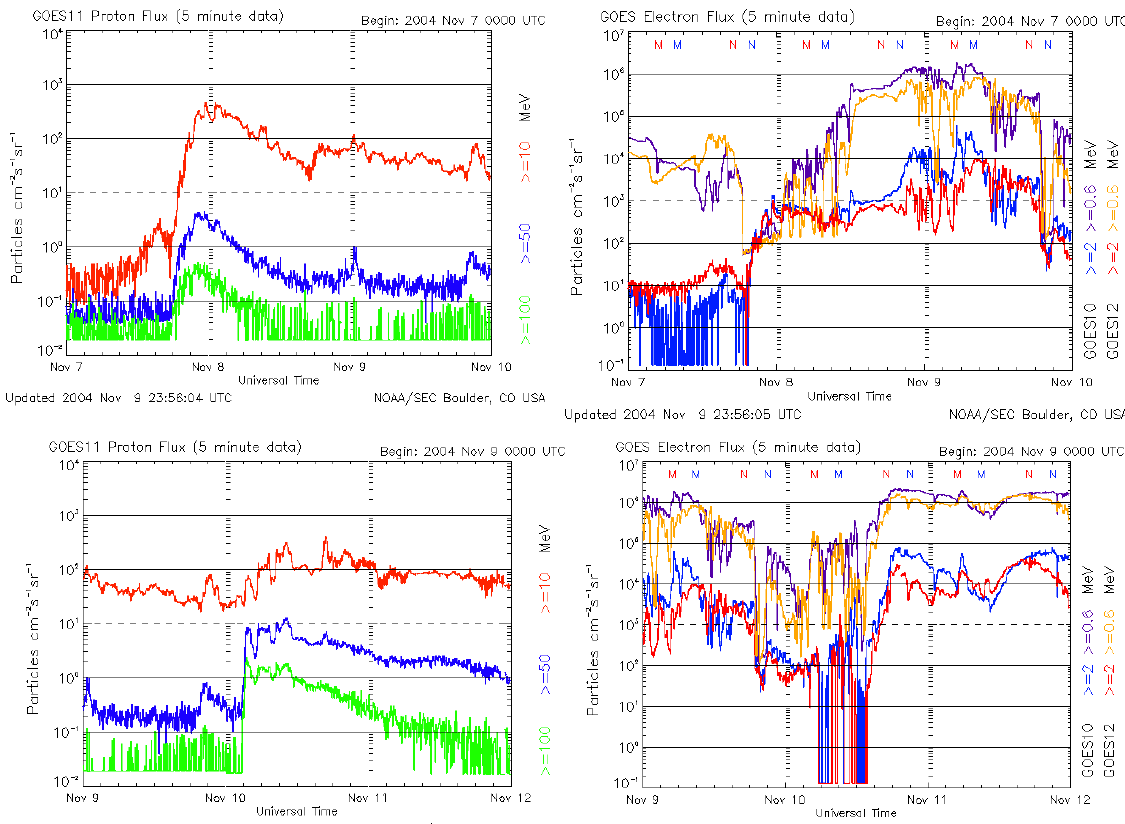
Fig. 19. (Top Left) GOES 11 (5-min) proton data recorded in three energy channels ( > 10MeV, > 50MeV, > 100MeV); (Top, Right) GOES 10 and GOES 12 (5-min) electron data recorded in two energy channels ( ≥ 0.6 and ≥ 2.0MeV), all between 7–10 November 2004; (Bottom Left) corresponding proton data and (bottom right) corresponding electron data similarly recorded between 9–12 November 2004.